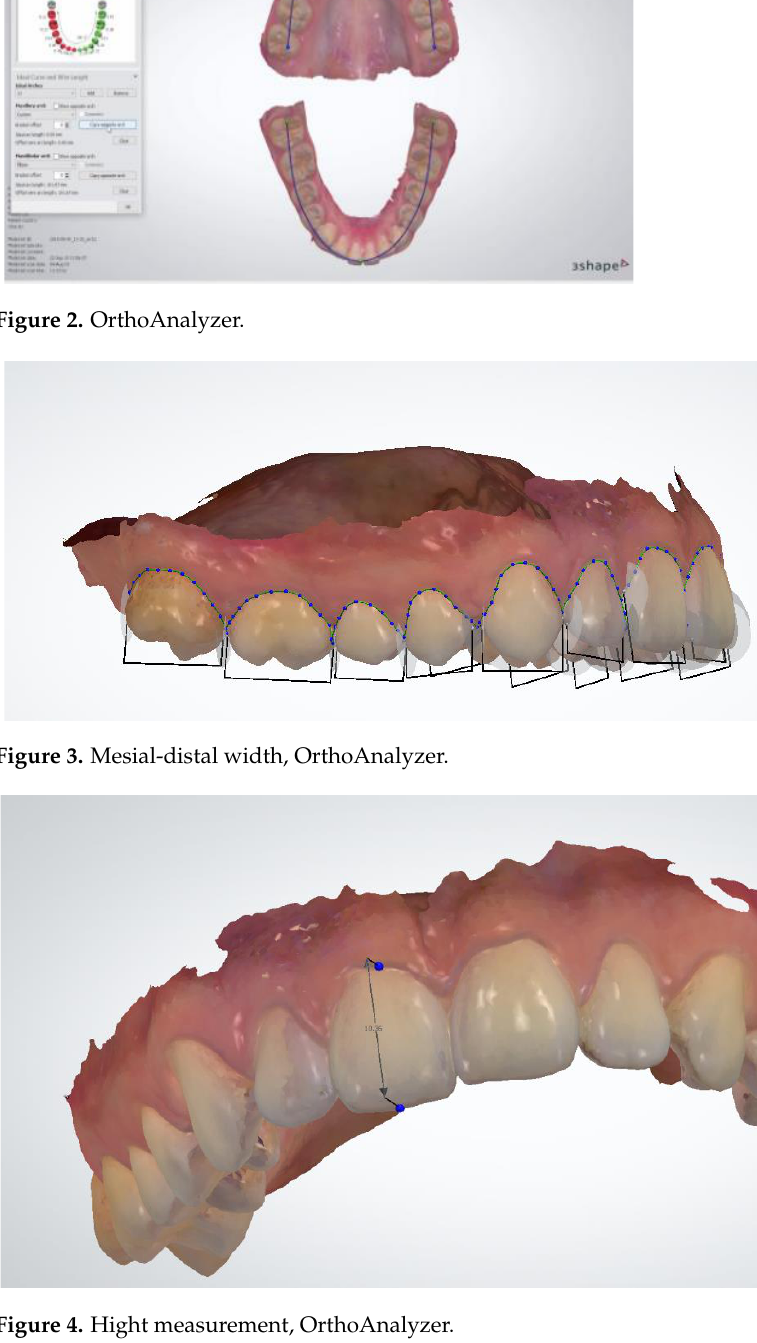
Figure 4. Hight measurement, OrthoAnalyzer.